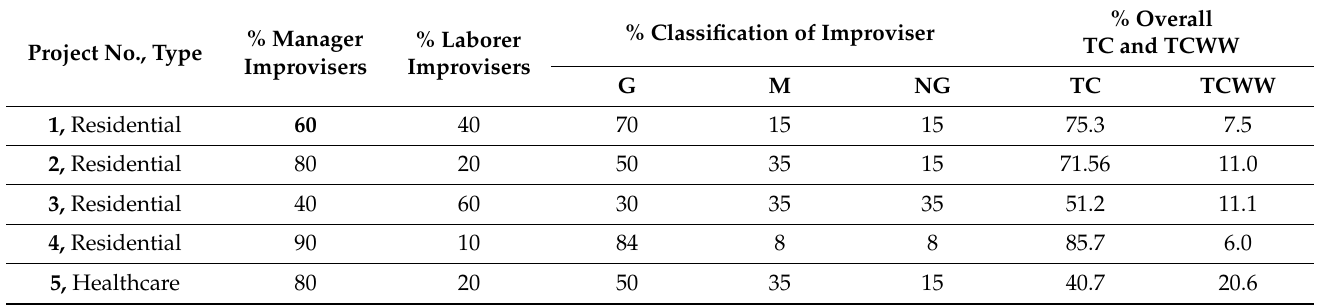
Table 7. Project inputs and